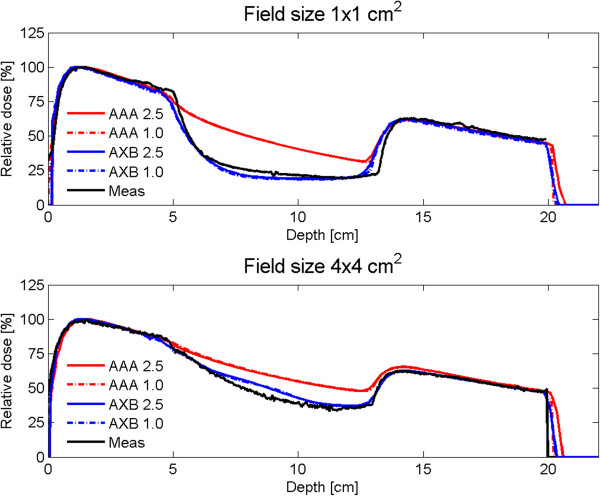
Measured and calculated percentage depth dose curves in a slab-phantom. Predicted percentage depth dose curves by AAA and Acuros XB grid sizes 2.5 and 1.0 mm compared to measured data using a slab-phantom with (top) 1.0x1.0 cm2 and (bottom) 4.0x4.0 cm2 6 MV AP photon beams.